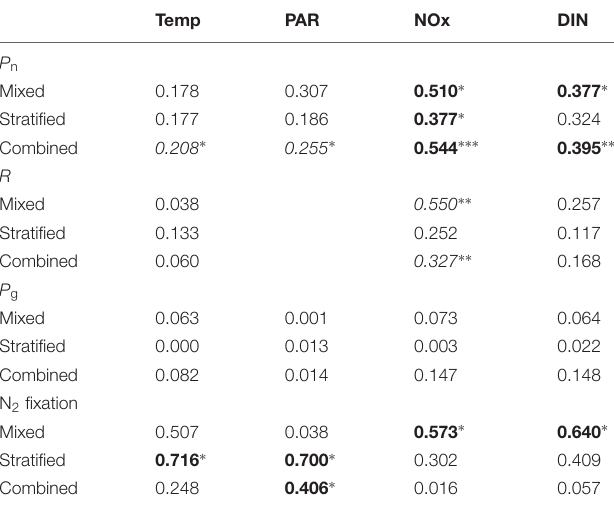
TABLE 3 | Linear regression analysis ( r 2 -values) examining the relationships between the physiological